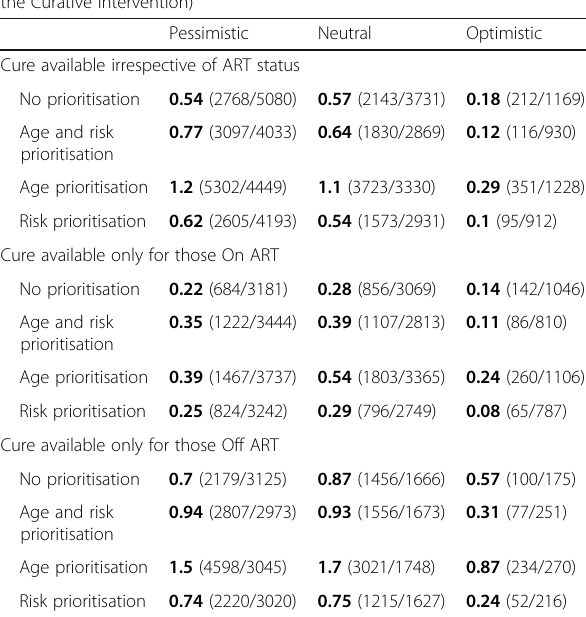
Table 2 Efficiency of curative intervention under different targeting scenarios